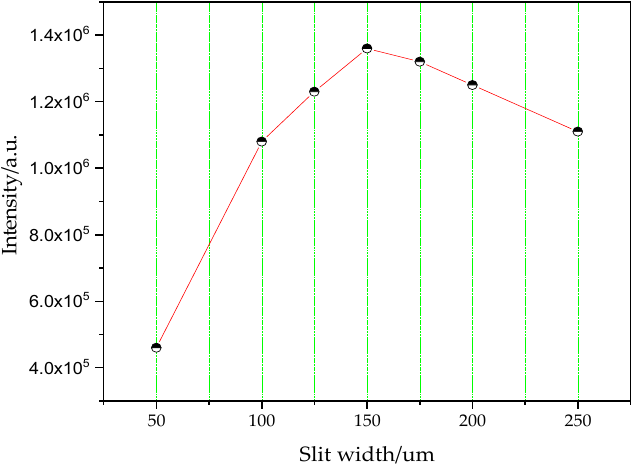
Figure 5. Raman intensity of 891 cm − 1 at different slit width.